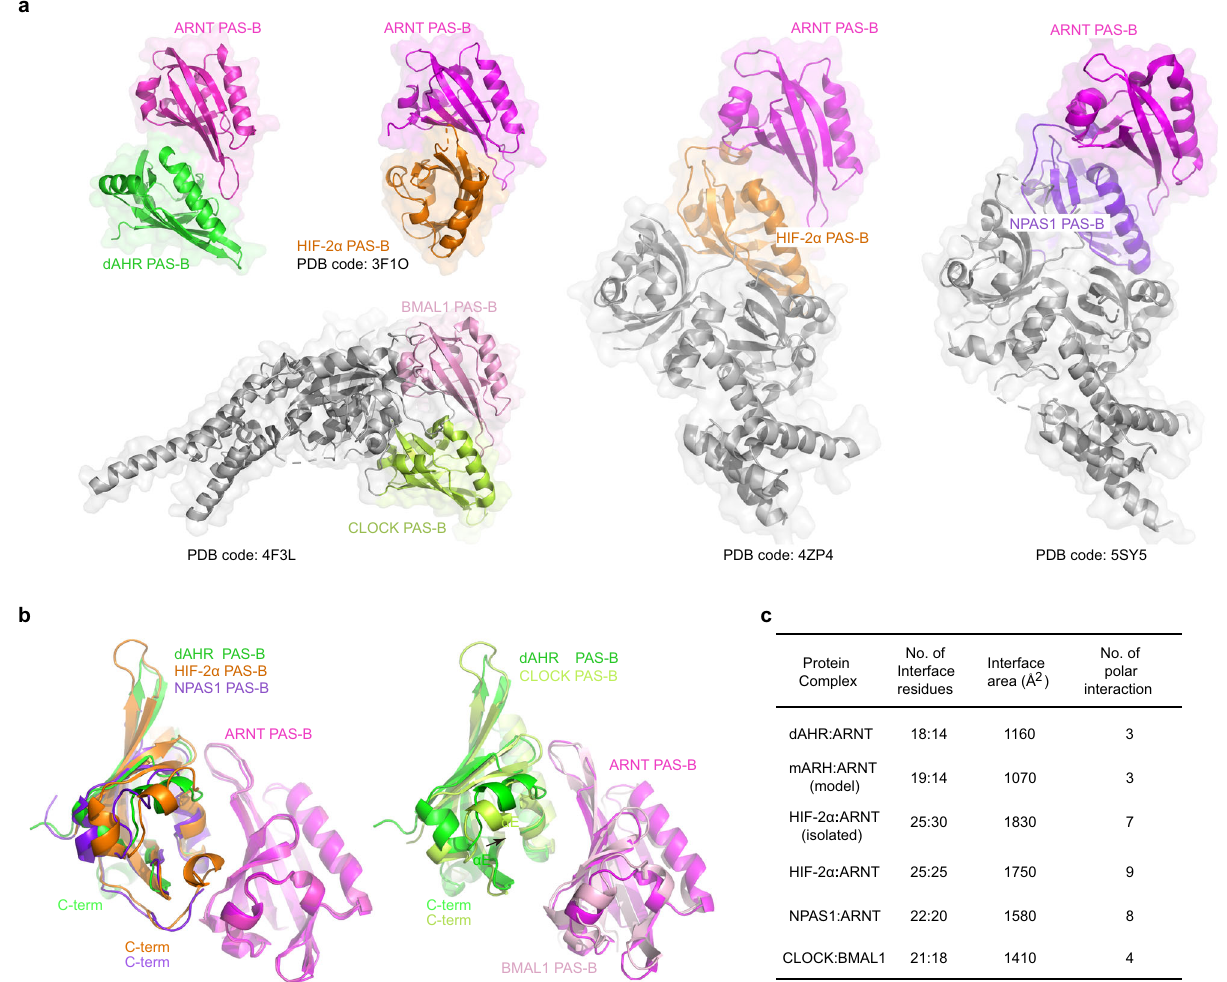
Fig. 6 | Comparison of the interaction interfaces of different PAS-B hetero- dimers. a PAS-B:PAS-B interaction interfaces observed in different bHLH-PAS het- erodimers. The PAS-B domains are highlighted, while other domains (bHLH and PAS-A) are shown in gray. b Superimposition of the PAS-B heterodimers. For